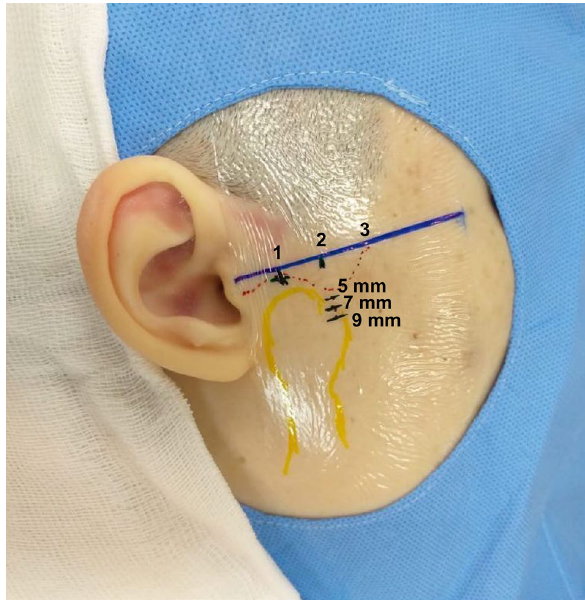
Figure 8. Reference points marked on a fresh frozen